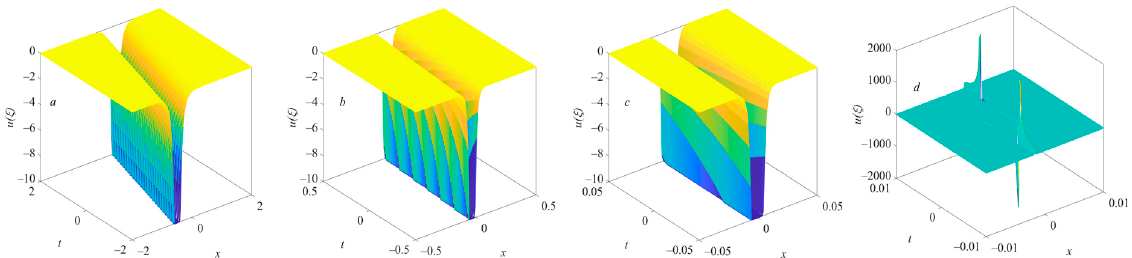
Figure 4. Evolution of solitary waves with n in u 4 n when k = 1: ( a ) n = 1, ( b ) n = 2, ( c ) n = 3, and ( d ) n = 4 .